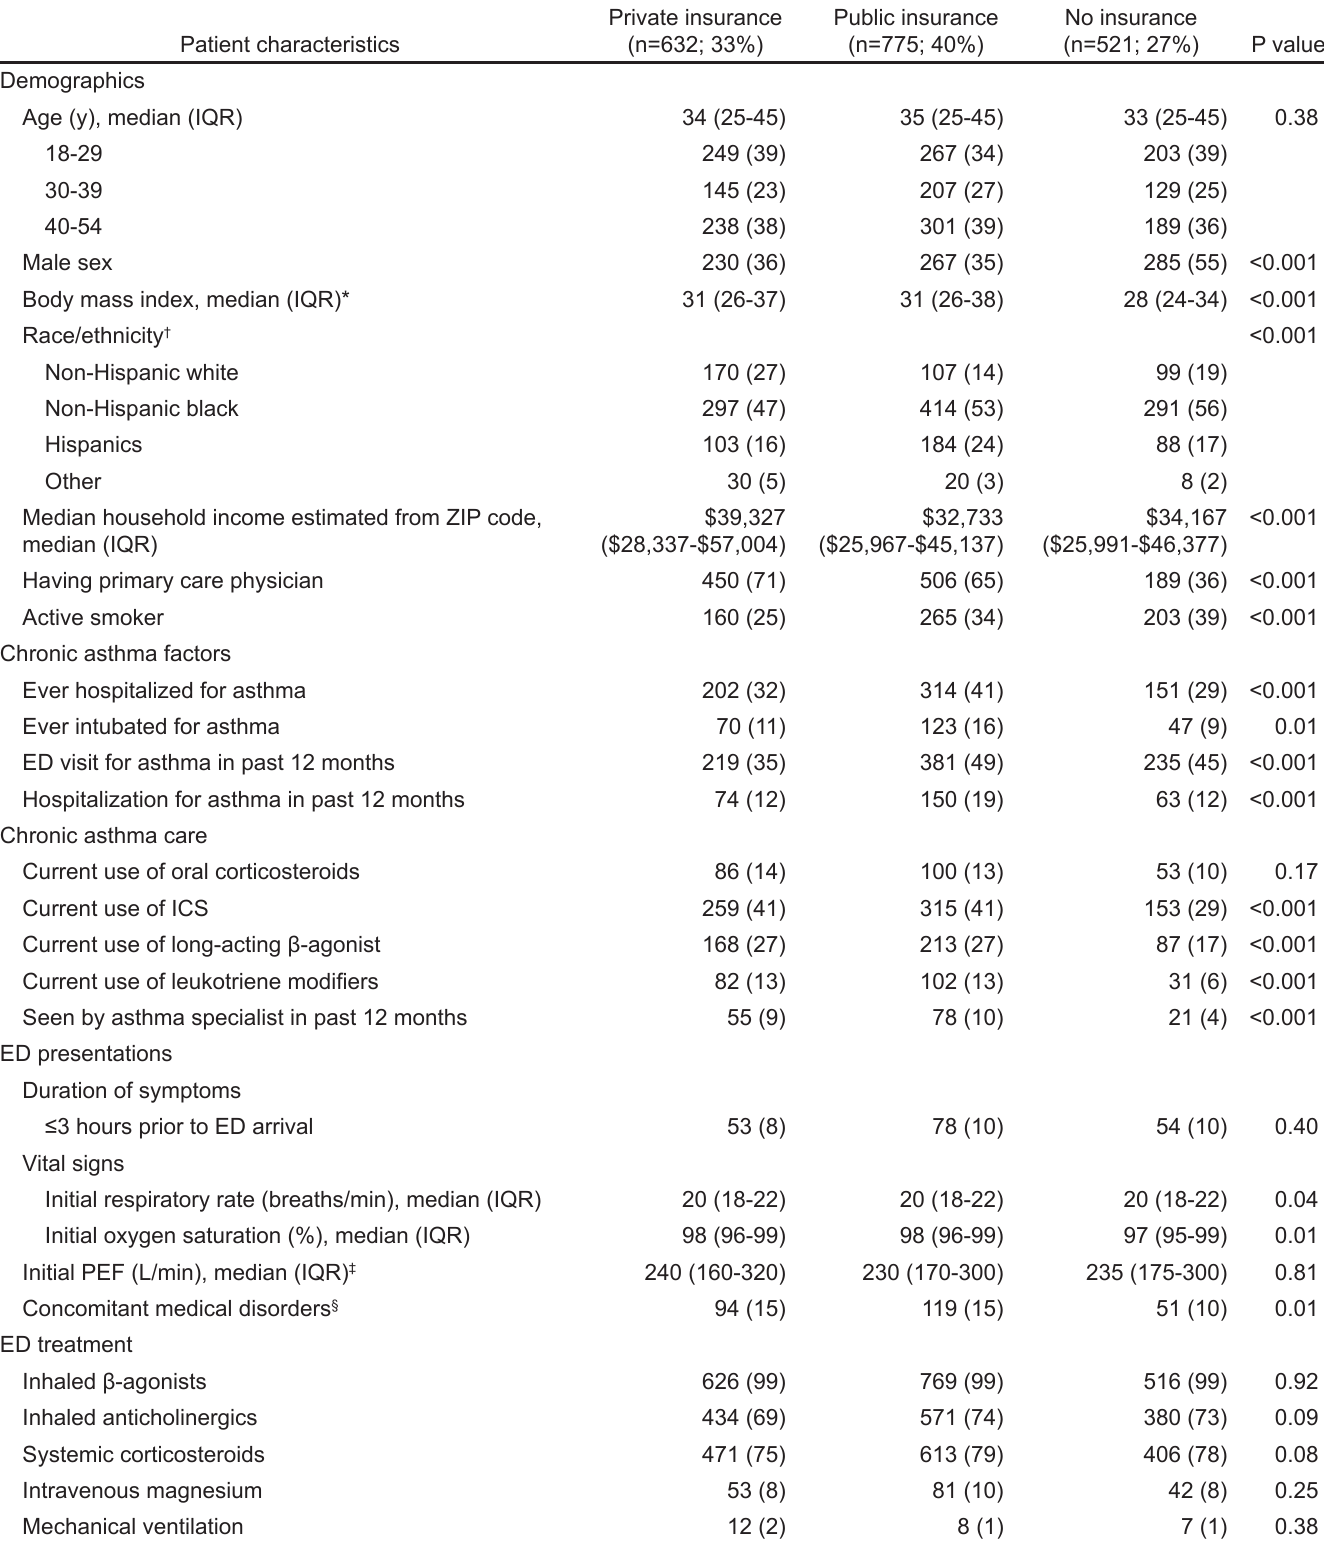
Table 1. Patient characteristics and emergency department course, according to primary insurance